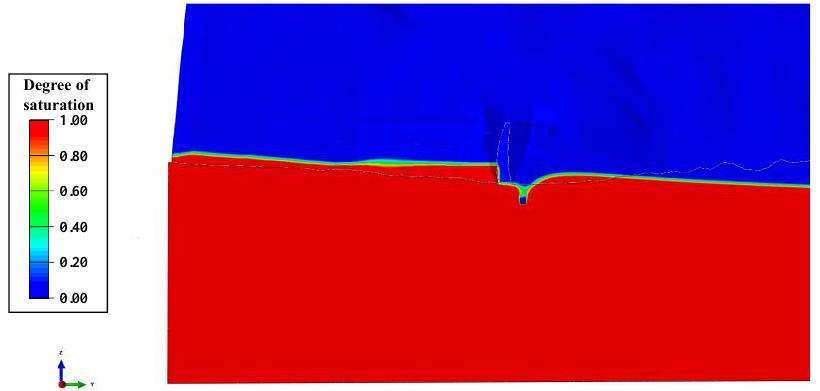
Figure 23. Numerical calculation results of the saturation degree of the first stage of the arch dam’s spillway section (water level: 1707 m).